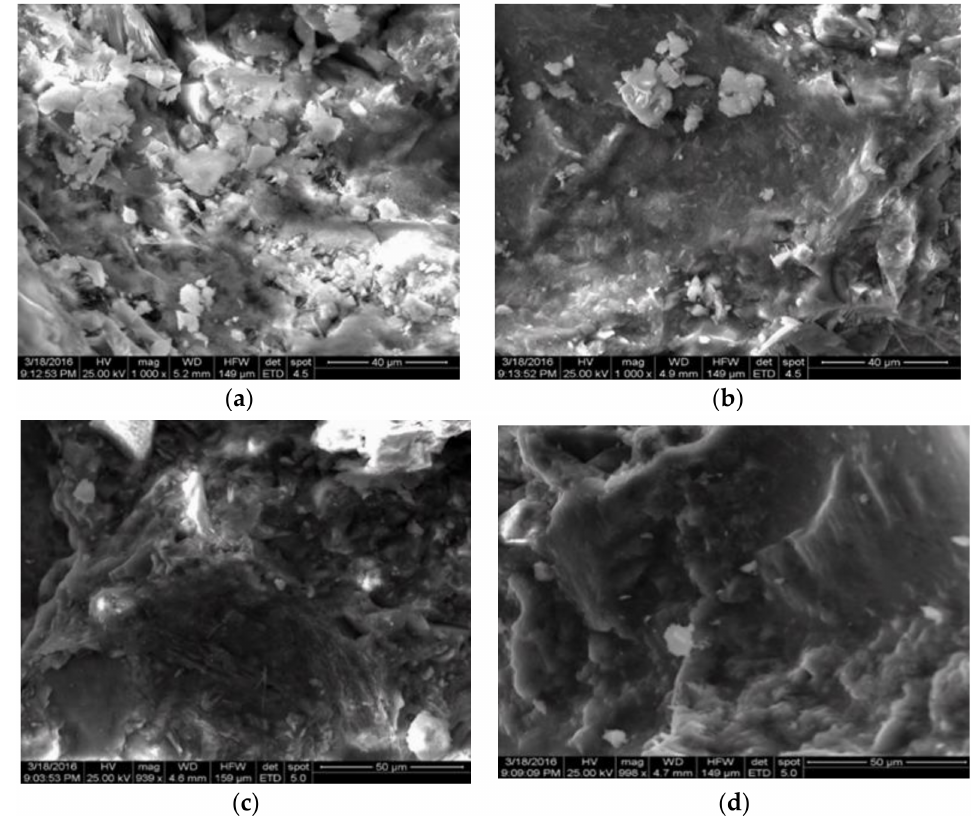
Figure 6. The structure of the modified multicomponent cement stone after hardening under normal conditions at the age of 28 days: ( a ) control composition; ( b ) with fine slag; ( c ) with fine slag and floured cement; ( d ) with fine slag, floured cement, and